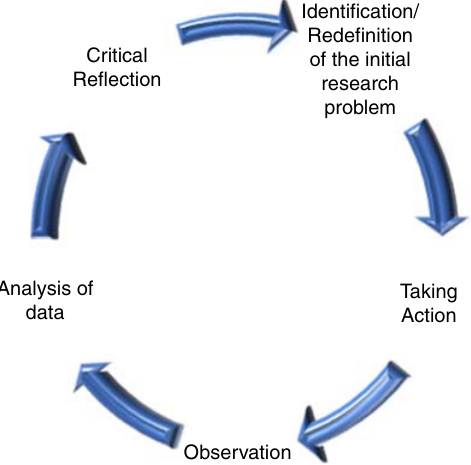
Figure 2. Phase of an AR